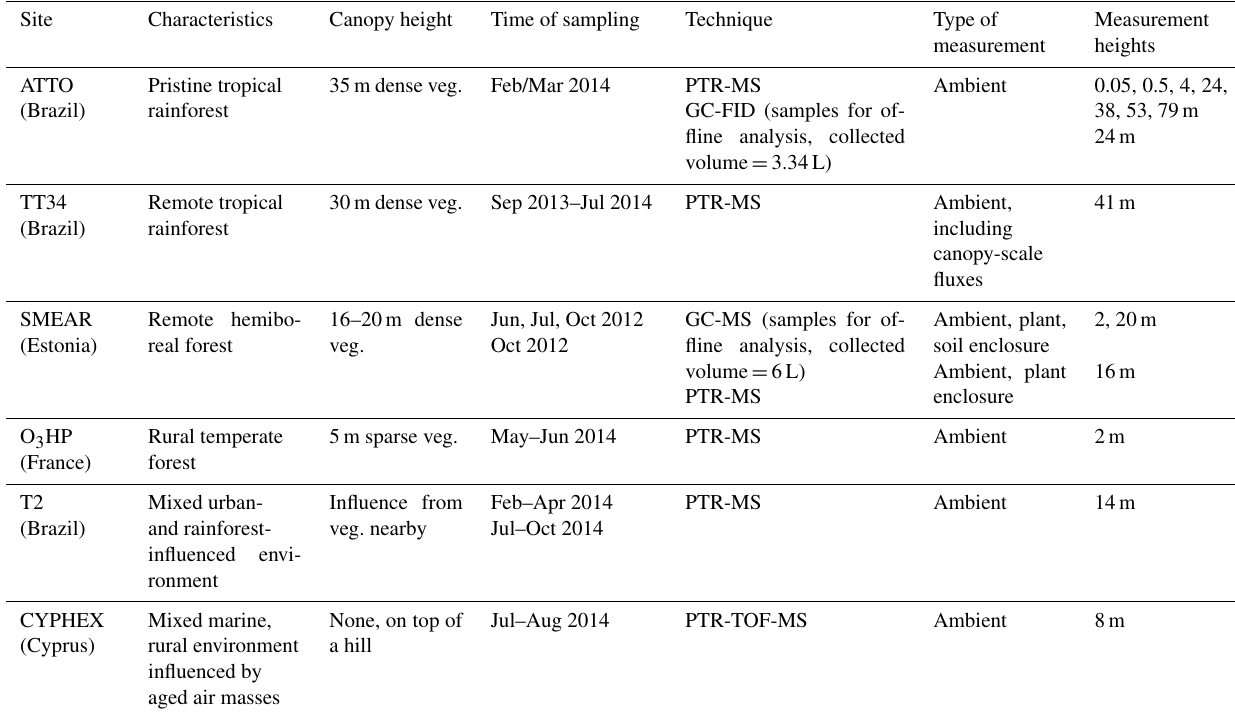
Table 1. Measurement sites, site environment, sampling dates, methods used and sampling heights. Site Technique Type of